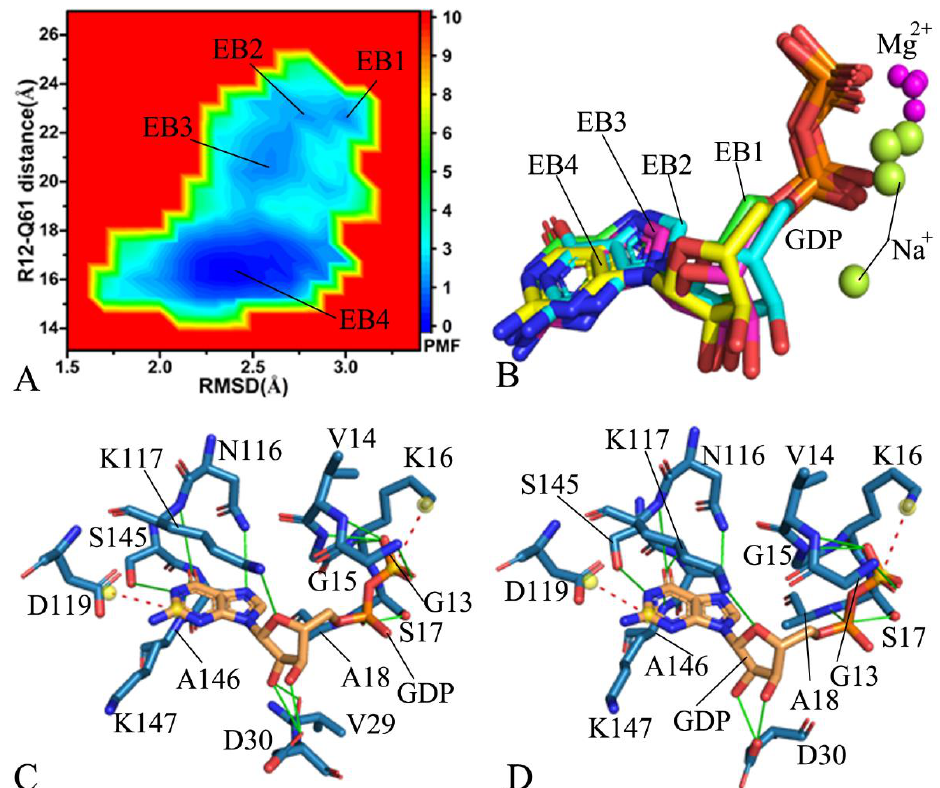
Figure 6. Free energy profile of structural information of the GDP-bound G12R KRAS: ( A ) the FEL built by using the RMSD and the distance of Y32 away from Q61, ( B ) superimposition of structures for GDP and magnesium ions in the EB1-EB4, ( C ) the GDP–residue interaction in the most incompact state of the switch domains, and ( D ) the GDP–residue interaction in the tightest state of the switch domains. The PMF is scaled in kcal/mol.